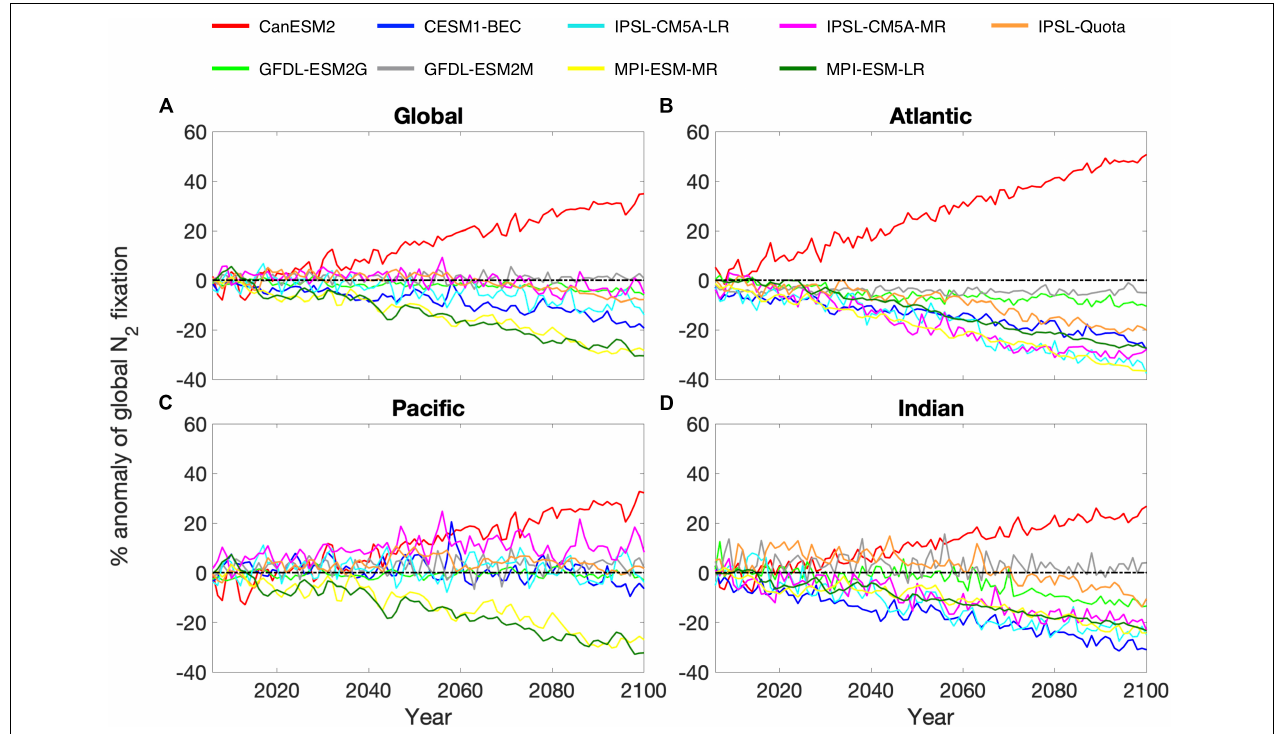
FIGURE 2 | Percentage anomaly of annual nitrogen fixation over the time period 2006–2100 for 4 regions: (A) the global ocean, (B) Atlantic Ocean, (C) Pacific Ocean, and (D) Indian Ocean. 9 nitrogen fixation models: CanESM2 (red), CESM1-BEC (blue), GFDL-ESM2G (light green), GFDL-ESM2M (gray), IPSL-CM5A-LR (cyan), IPSL-CM5A-MR (magenta), IPSL-Quota (orange), MPI-ESM-LR (yellow) and MPI-ESM-MR (dark green). Black dashed line indicates the zero